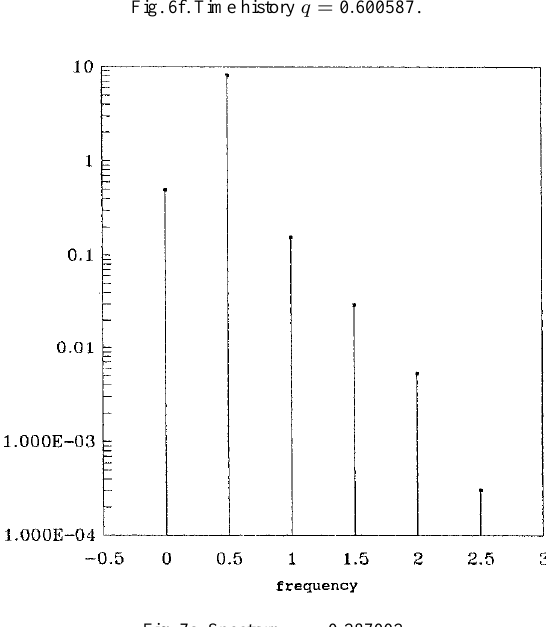
Fig. 7a. Spectrum q = 0 : 287002.